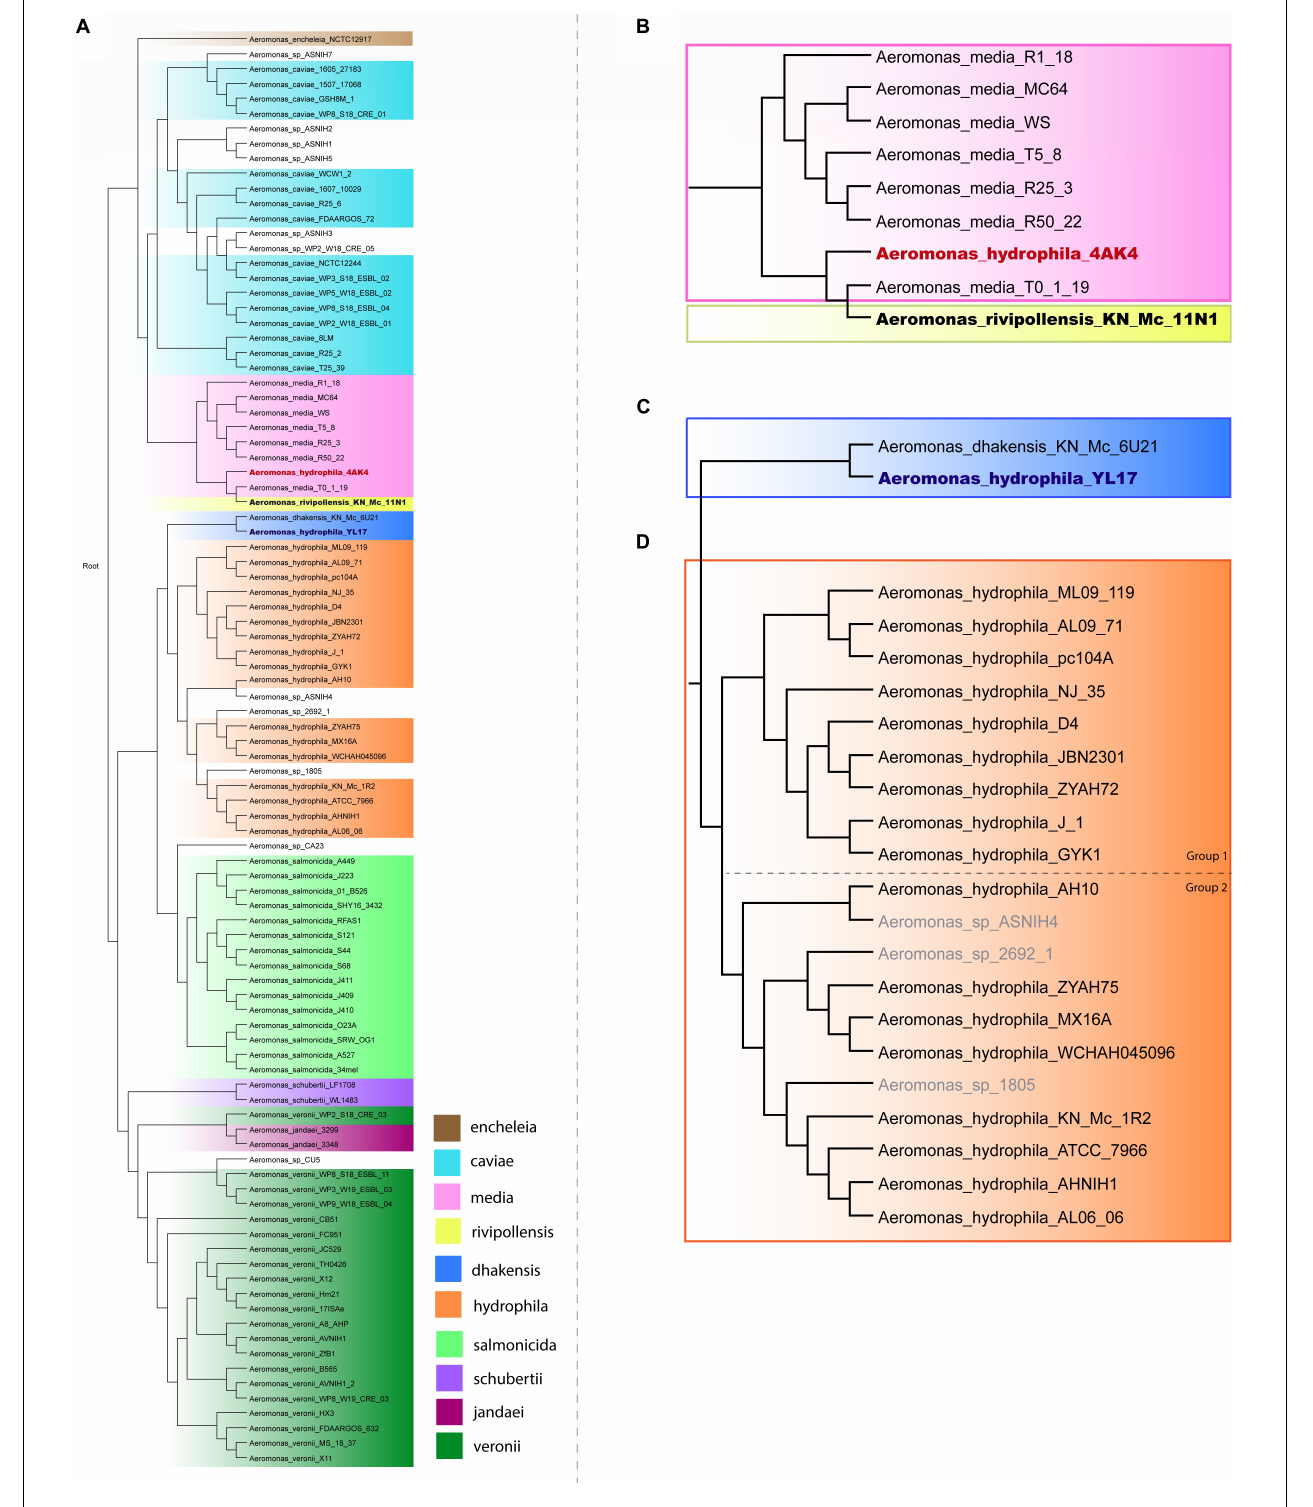
FIGURE 1 | Phylogenetic tree of the Aeromonas species. (A) Phylogenetic tree generated from the whole genome of 96 Aeromonas strains. (B) Highlighted branch of “ A. hydrophila 4AK4.” (C) Highlighted branch of “ A. hydrophila YL17.” (D) Highlighted branch of A. hydrophila ; s trains analyzed are subgrouped into two main subclades, separated by dotted lines: ML09-119, AL09-71, pc104A, NJ-35, D4, JBN2301, ZYAH72, J-1, and GYK1 (group 1); AH10, ZYAH75, MX16A, WCHAH045096, KN-Mc-1R2, ATCC 7966, AHNIH1, and AL06-06 (group 2).